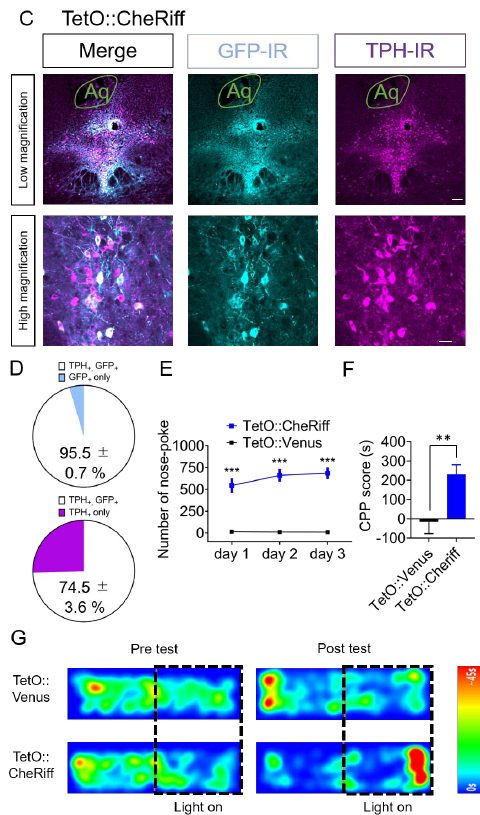
Figure 3. E ff ect of the optogenetic activation of DRN 5-HT neurons targeted by Tph2-tTA transgenic mice in the nose-poke self-stimulation test and CPP test. ( A ) Schematic of the experiment. ( B , C ) Four weeks after injection, coronal sections containing the dorsal raphe nucleus (DRN) were prepared and stained by anti-green fluorescent protein (GFP) and anti-tryptophan hydroxylase (TPH) antibodies. Stained sections were imaged using confocal microscopy. Scale bars = 100 µ m (low magnification), 20 µ m (high magnification). Aq, Aqueduct. ( D ) The number of TPH- and GFP-immunoreactive cells in TetO::Venus injected animals were counted. (Top) Data represent mean ± SEM of the percentage of double-positive cells in GFP-positive cells. (Bottom) Data represent mean ± SEM of the percentage of double-positive cells in TPH-positive cells. n = 3 mice. ( E ) After injection of TetO::Venus or TetO::CheRi ff in mTph2-tTA mice, the number of nose-poke responses in the operant chamber was measured. Blue light (20 Hz, 10 ms duration, 20 pulses, 5 mW) was delivered when mice performed nose-poke responses. Data represent mean ± SEM. n = 9 (Venus), 16 (CheRi ff ) mice. *** p < 0.001 vs. Venus (Day 1; TetO::Venus, 15.4 ± 6.5, TetO::CheRi ff , 544.2 ± 83.9, Day 2; TetO::Venus, 11.8 ± 3.6, TetO::CheRi ff , 660.4 ± 72.0, Day 3; TetO::Venus, 10.1 ± 2.4, TetO::CheRi ff , 684.7 ± 67.5; two-way repeated-measures ANOVA; Interaction, F(2, 46) = 2.454, p = 0.0972, Time, F(1.972, 45.36) = 2.125, p = 0.1318, Opto, F(1, 23) = 44.80, p < 0.001, Subject, F(23, 46) = 10.34, p < 0.001; Bonferroni posttests; Day 1–3, *** p < 0.001). ( F ) In the conditioned place preference (CPP) test, spent time in the chamber associated with blue light illumination to the DRN were examined. Data represent mean + or − SEM. n = 6 (Venus), n = 7 (CheRi ff ) mice. ** p < 0.01 vs. Venus. (Venus, − 16.67 ± 60.36 s, CheRi ff , 230.5 ± 50.1 s; unpaired t -test; p = 0.0088). ( G ) Representative heat map of mouse movement during the pretest at Day 1 and posttest at Day